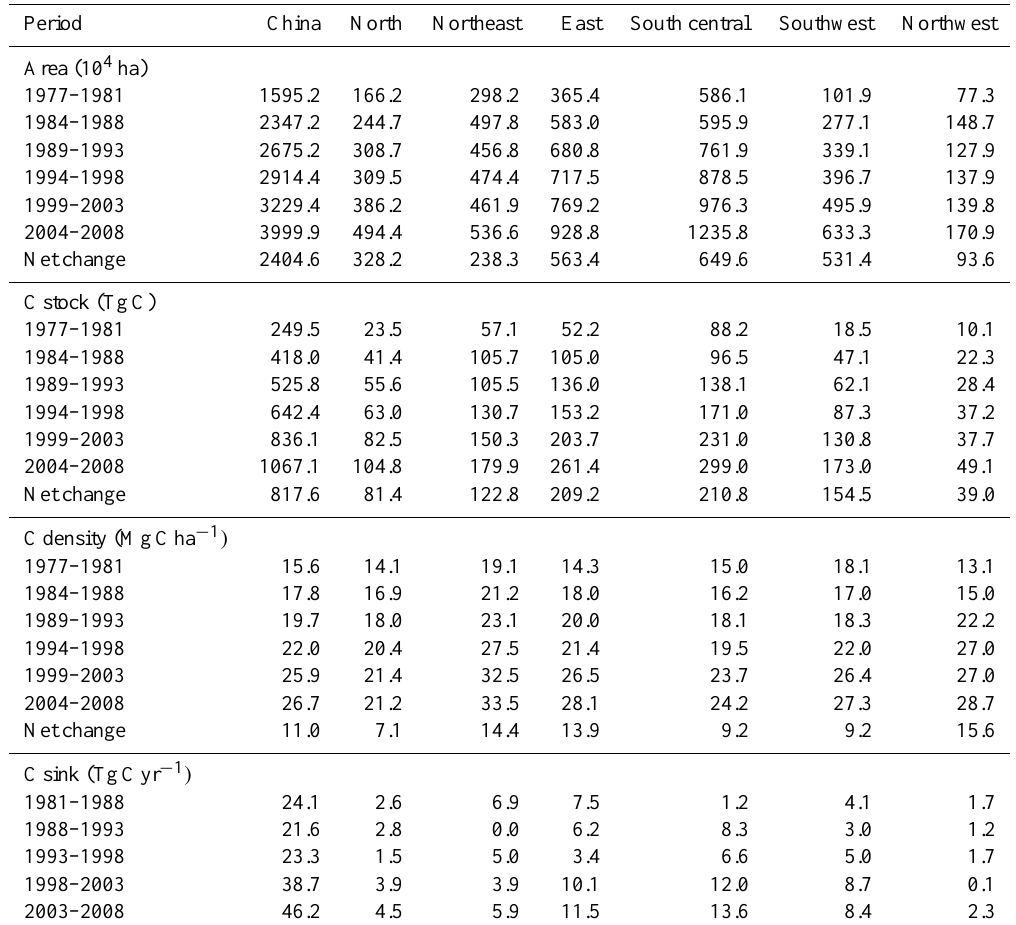
Table A1. Forest area, carbon stock, and carbon sinks of planted forests for six regions in China from 1977 to 2008. Period China